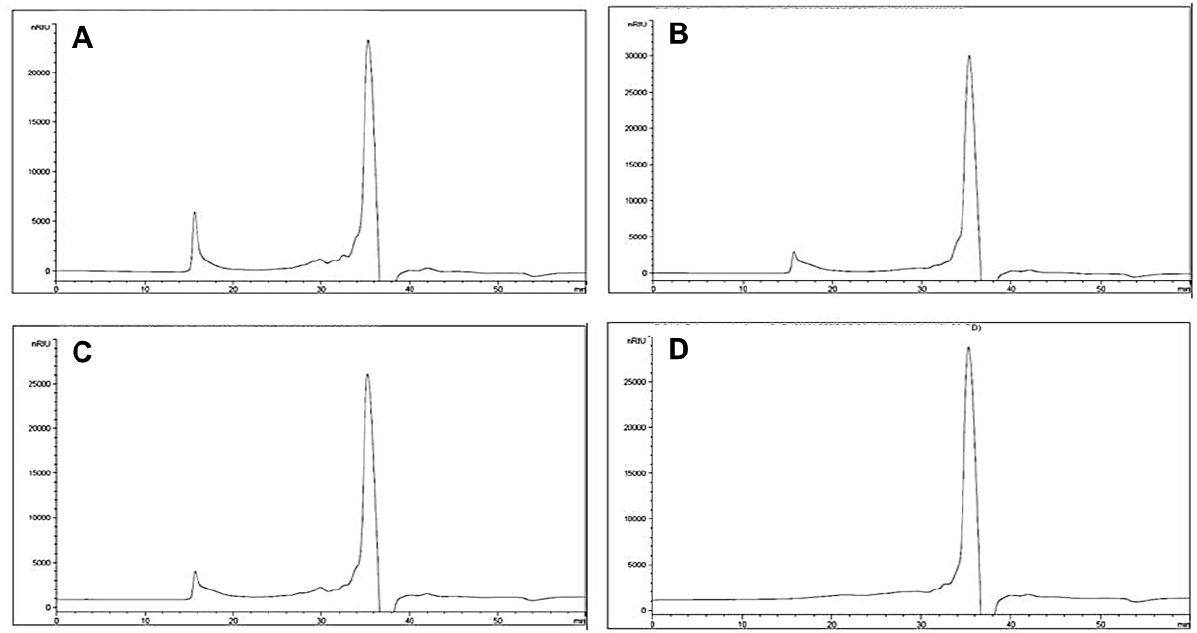
Figure 1. Changes of HPLC chromatogram with different types of enzyme and incubating times using citrus peel hydrolysate (CPH). ( A ), Pectinex Ultra SP-L 3 h; ( B ), Pectinex Ultra SP-L 12 h; ( C ), Pectinex Ultra Pulp 3 h; ( D ), Pectinex Ultra Pulp 12 h.